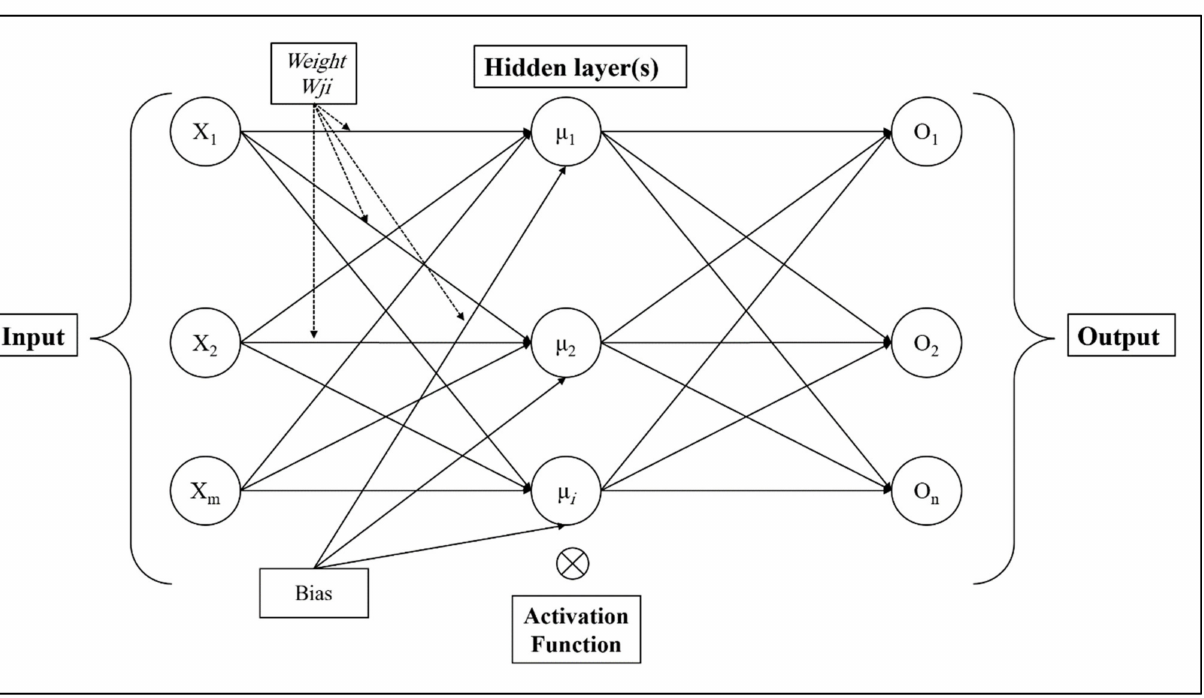
Figure 2. Simple architecture of